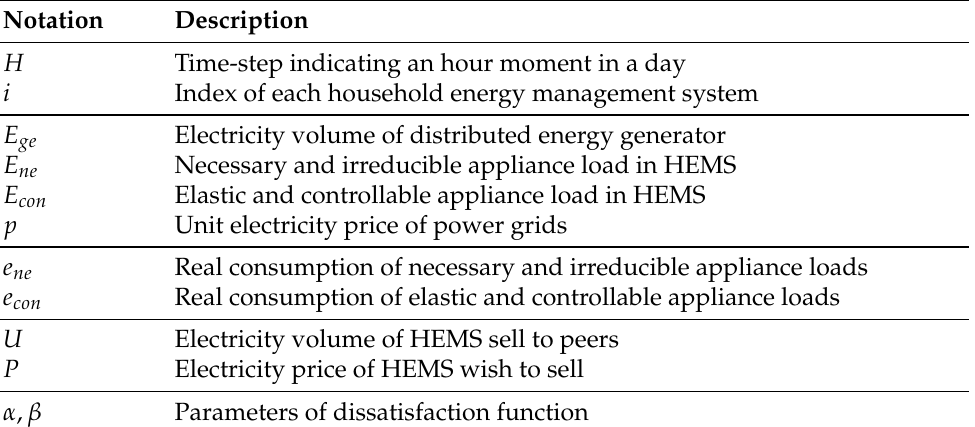
Table 1. Parameter notations of peer-to-peer energy trading system